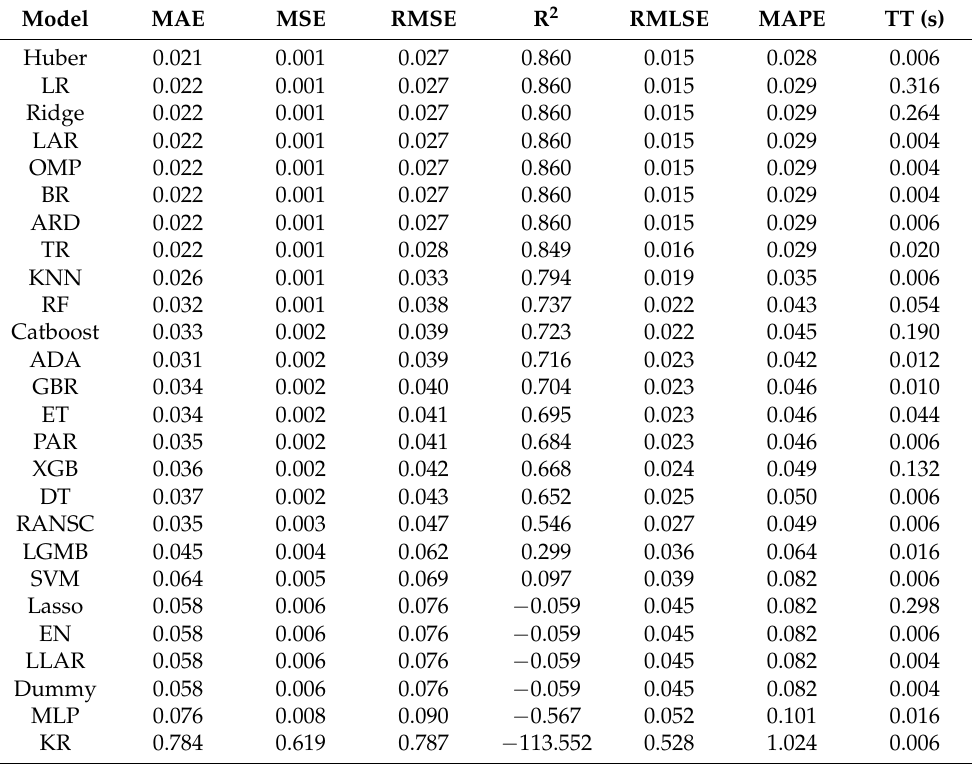
Table 10. Accuracy assessment of different estimation models based on MS vegetation indices.